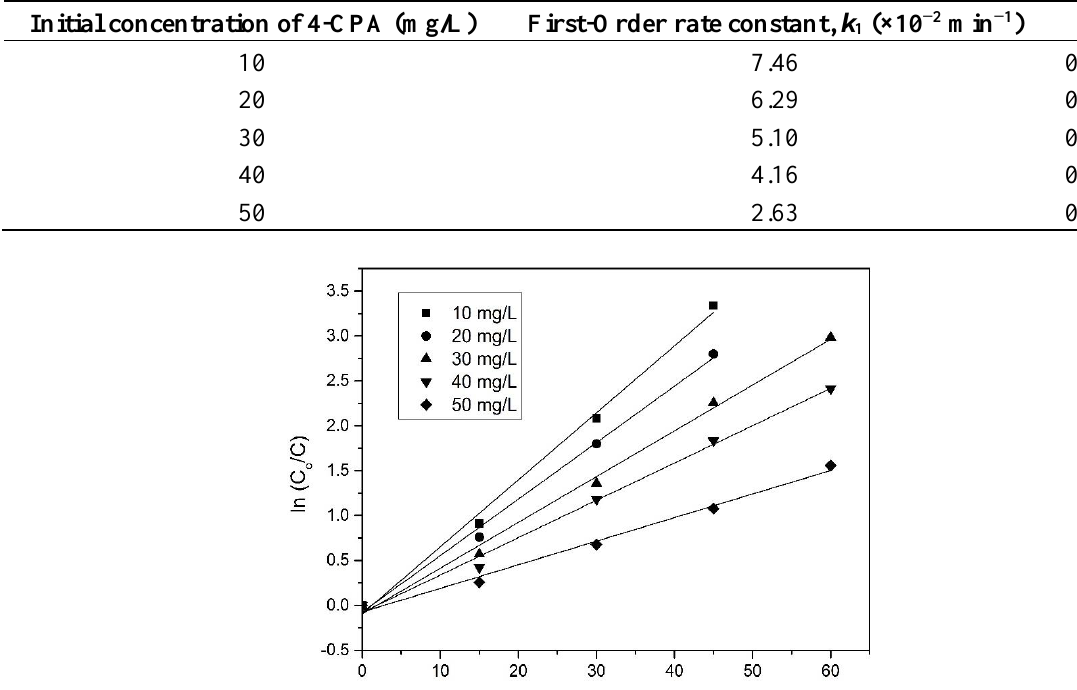
of photodecompositon of 4-CPA. 1